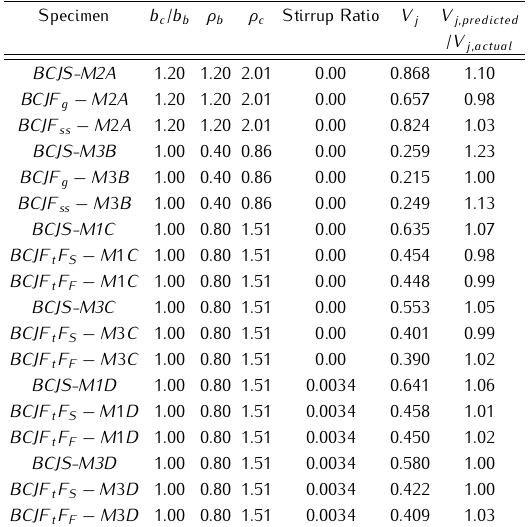
Table 5. Influencing parameters on joint shear strength.